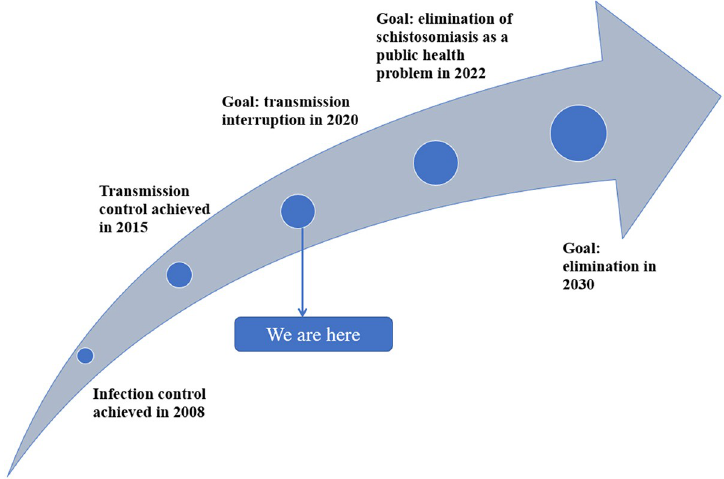
Fig 3. Overall progress of schistosomiasis elimination in the